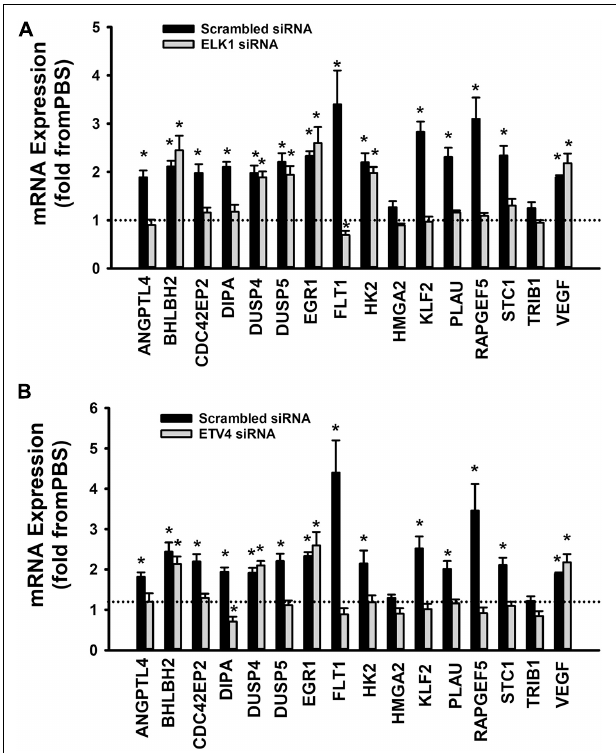
FIGURE 10 | Contributions of ELK1 and ETV4 to Ang-1-induced gene expression. (A) Effects of Ang-1 (300 ng/ml) on mRNA expressions of various genes in HUVECs transfected with scrambled or ELK1 siRNA oligos. Cells maintained in basic medium containing PBS or Ang-1 for 4 h. Values are means ± SEM, expressed as fold from PBS. * P < 0.05, compared to PBS. N = 6 per group. (B) Effects of Ang-1 (300 ng/ml) on mRNA expressions of various genes in HUVECs transfected with scrambled or ETV4 siRNA oligos. Cells maintained in basic medium containing PBS or Ang-1 for 4 h. Values are means ± SEM, expressed as fold from PBS. * P < 0.05, compared to PBS. N = 6 per